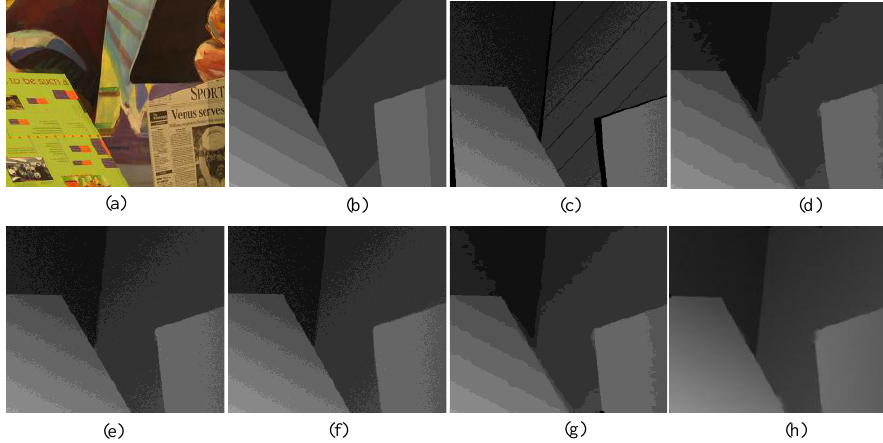
Figure 17. Results for Venus from the Middlebury database: ( a ) Color image; ( b ) Original depth map (right view); ( c ) Noisy image; ( d ) JBF; ( e ) FMI; ( f ) GFMI; ( g ) GFMIGF; ( h ) Proposed method.